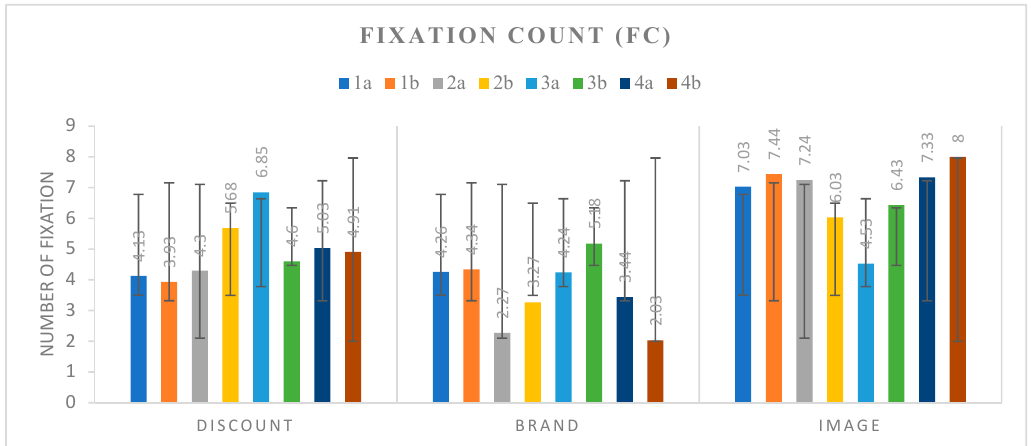
Figure 2. Distribution of the Fixation Count for the banners in the three AOIs.